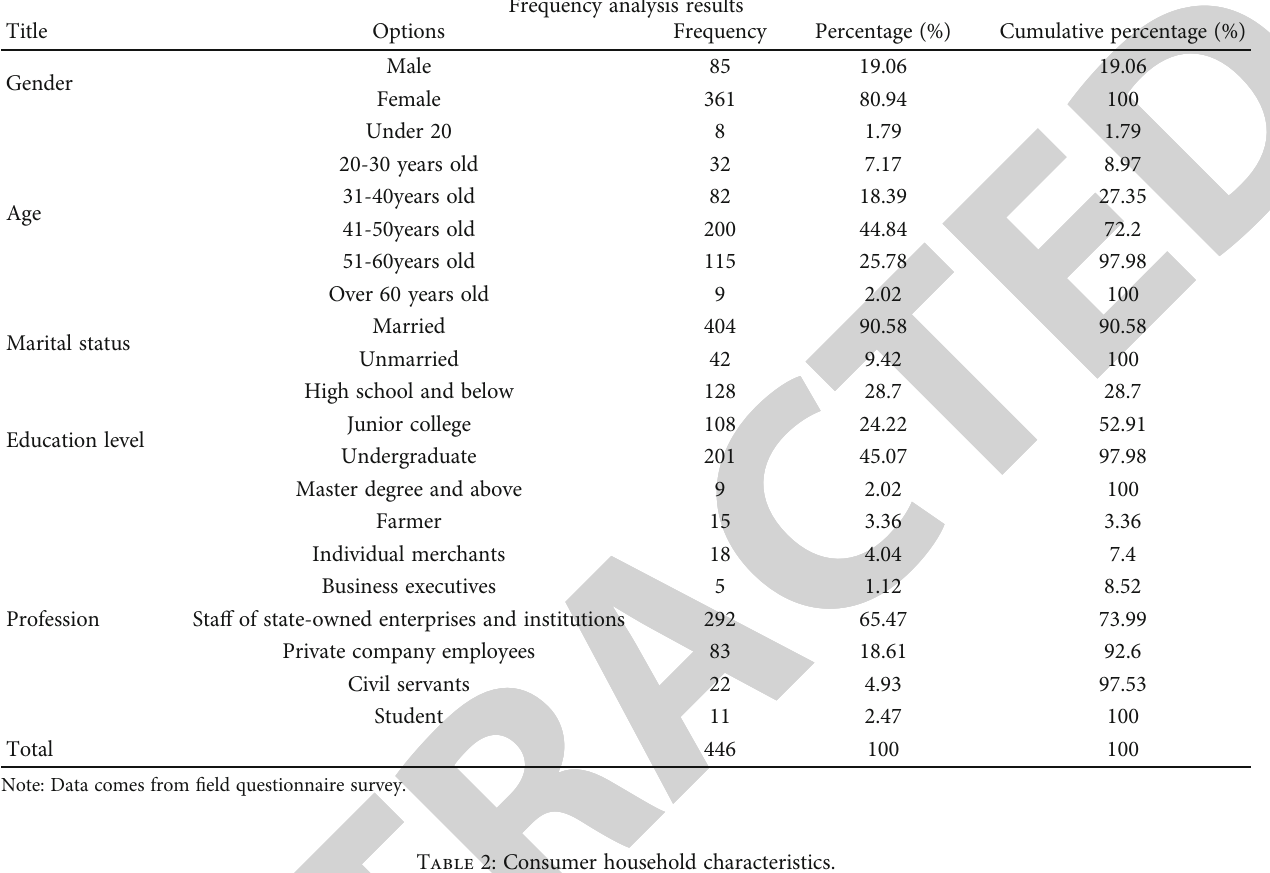
Table 1: Consumer characteristics. Frequency analysis